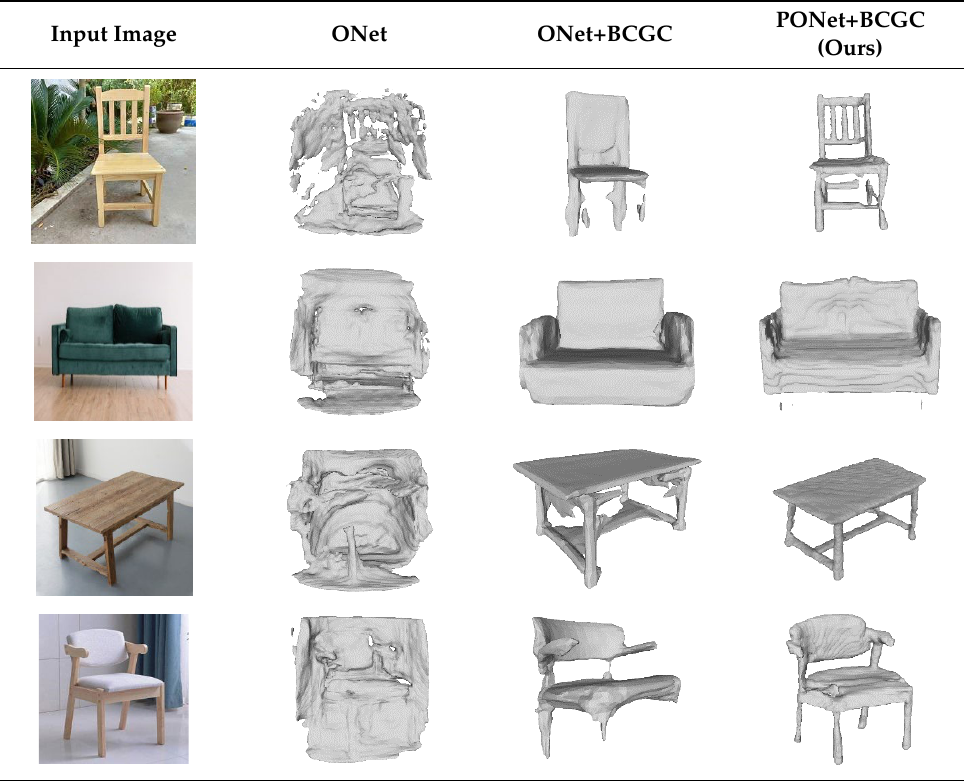
Figure 9. Image repeatability comparison. ( a ) Increasing Blur ( b ) Viewpoint ( c ) Compression ( d ) Rotation.